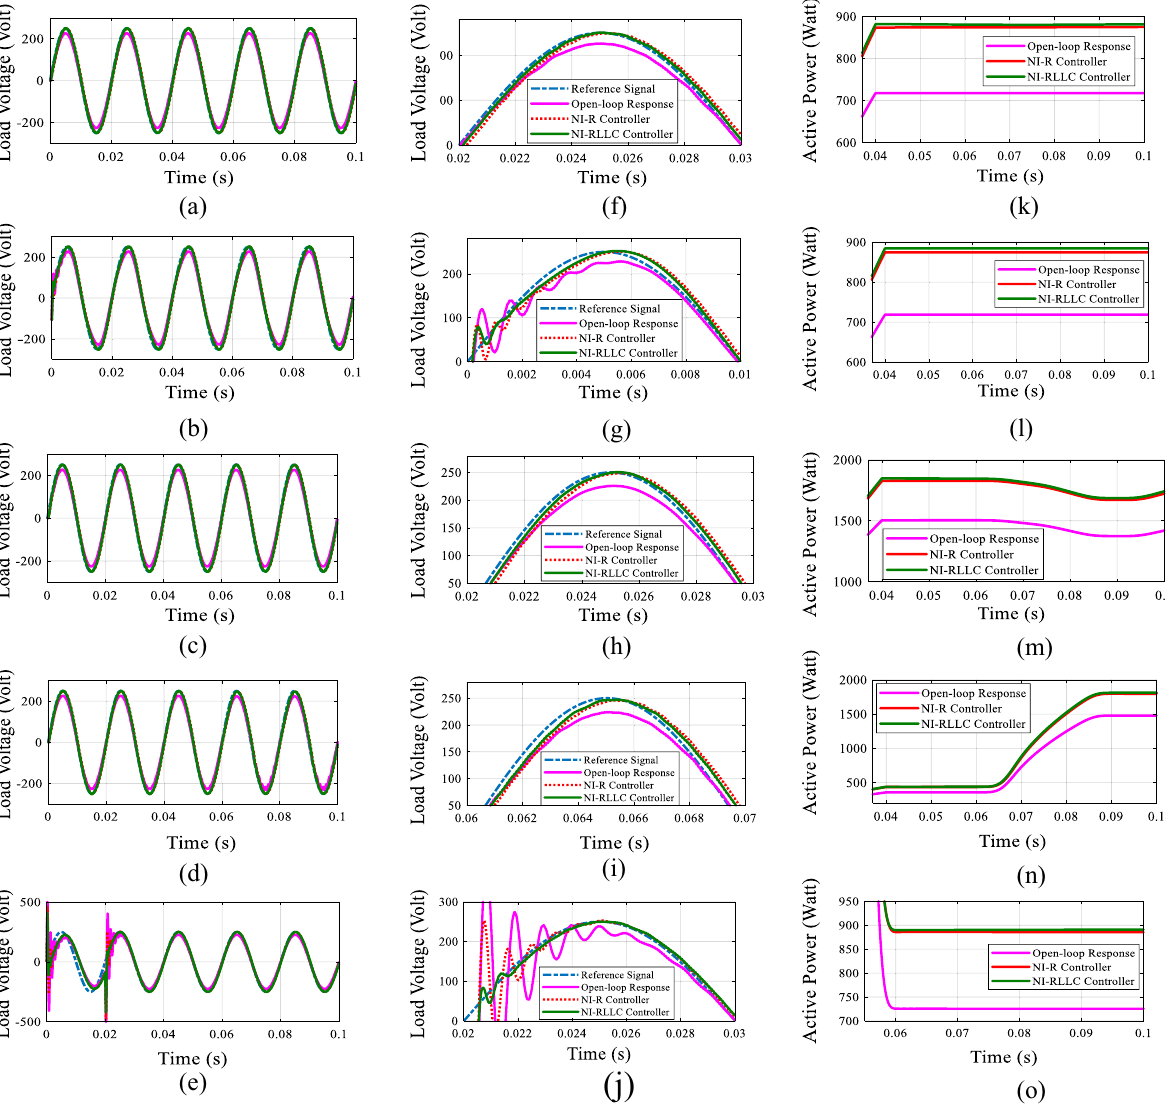
Fig. 11 Single‑phase load voltage comparison of load a consumer, b harmonic, c unknown, d nonlinear, e dynamic. Zoomed view of load voltage of load f consumer, g harmonic, h unknown, i nonlinear, and j dynamic. Active power measurement of load k consumer, l harmonic, m unknown, n nonlinear and o